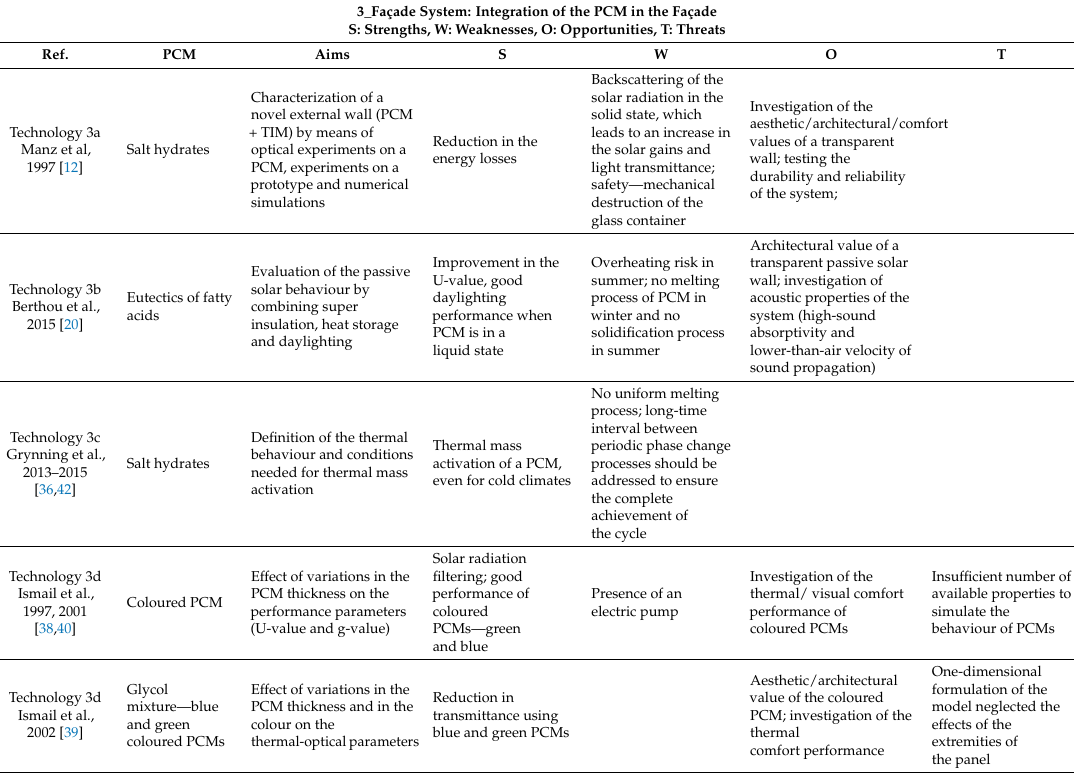
Table 5. SWOT analysis of PCM in the